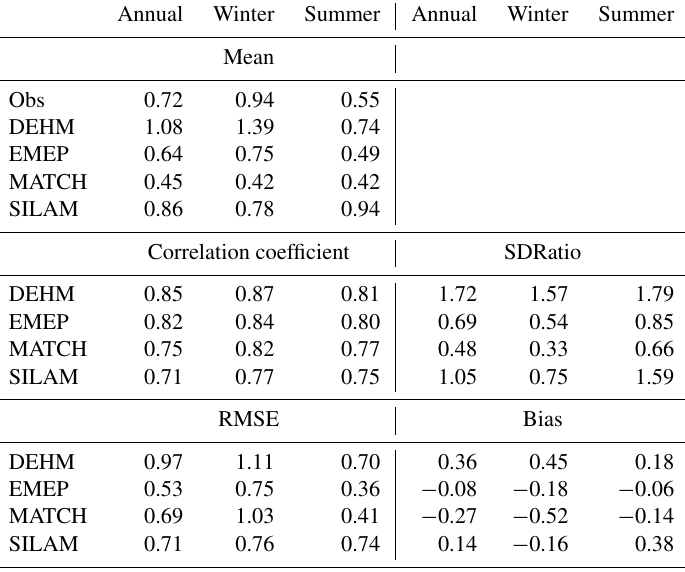
Table 3. Statistical evaluation of model results for surface SSA concentration (µgNa + m − 3 ), considering the whole year (annual), winter (December, January, and February), and summer periods (June, July, and August), for 33 EMEP measuring sites, between 1990 and